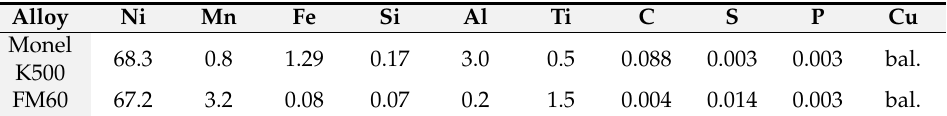
Table 1. The chemical compositions of Monel K500 and FM60 used in the study (wt.%). Alloy Ni Mn Fe Si Al Ti C S P Cu Monel 68.3 0.8 1.29 0.17 3.0 0.5 0.088 0.003 0.003 bal. K500 FM60 67.2 3.2 0.08 0.07 0.2 1.5 0.004 0.014 0.003